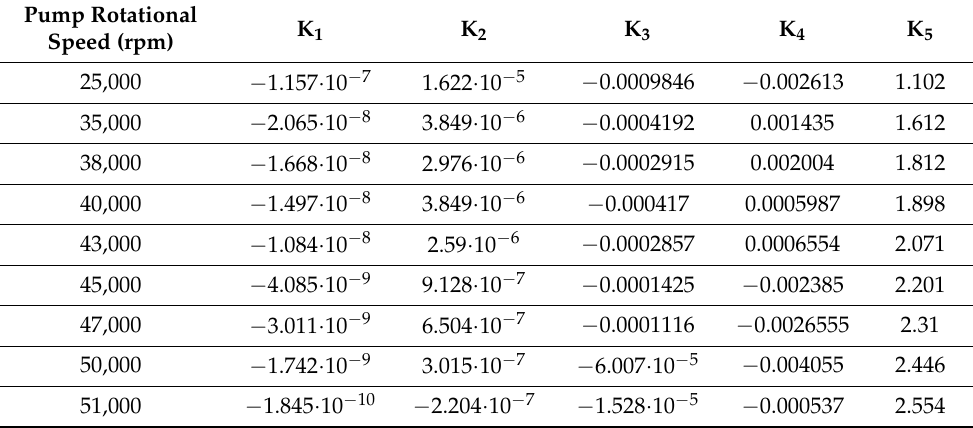
Figure 3. Schematic representation of the cardiovascular system assembled with the IMPELLA 2.5 pump. Table 1. Numerical model parameters for Impella